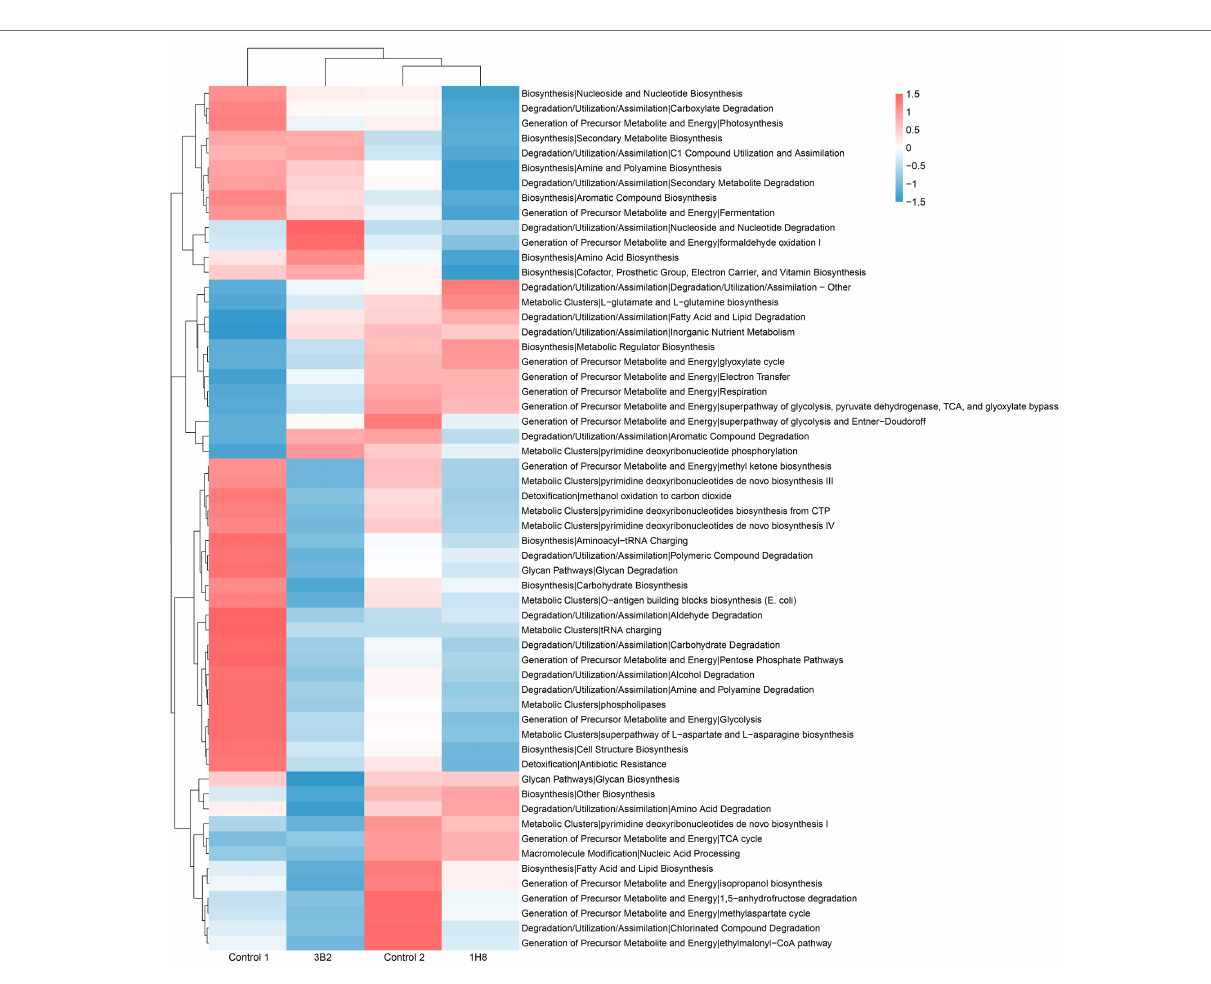
FIGURE 4 | The relative abundance of bacterial metabolic pathway in cigar tobacco